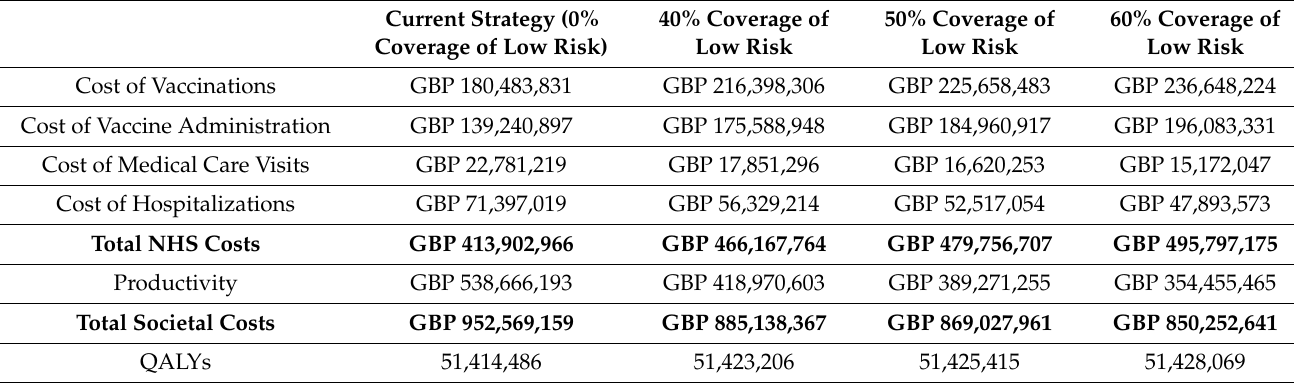
Table 4. Base case results: the average annual discounted costs and quality-adjusted life-years with different level of coverage of low risk individuals aged 50 to 64 years old.